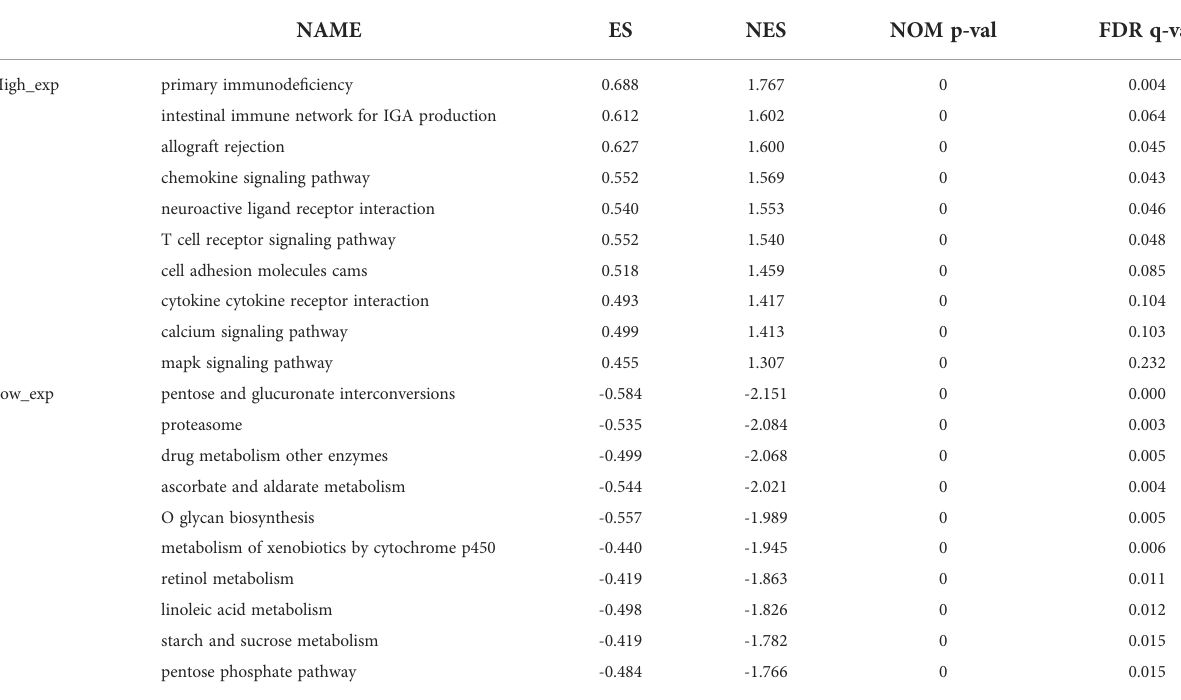
TABLE 2 KEGG pathway enrichment of